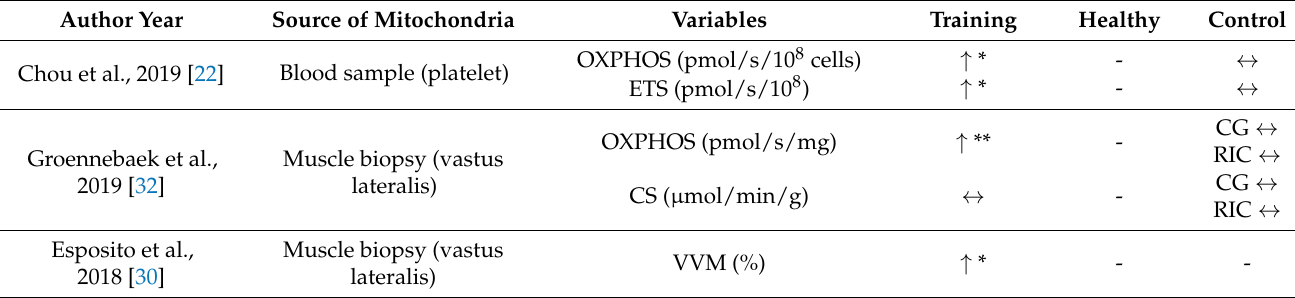
Table 4. Results on mitochondrial